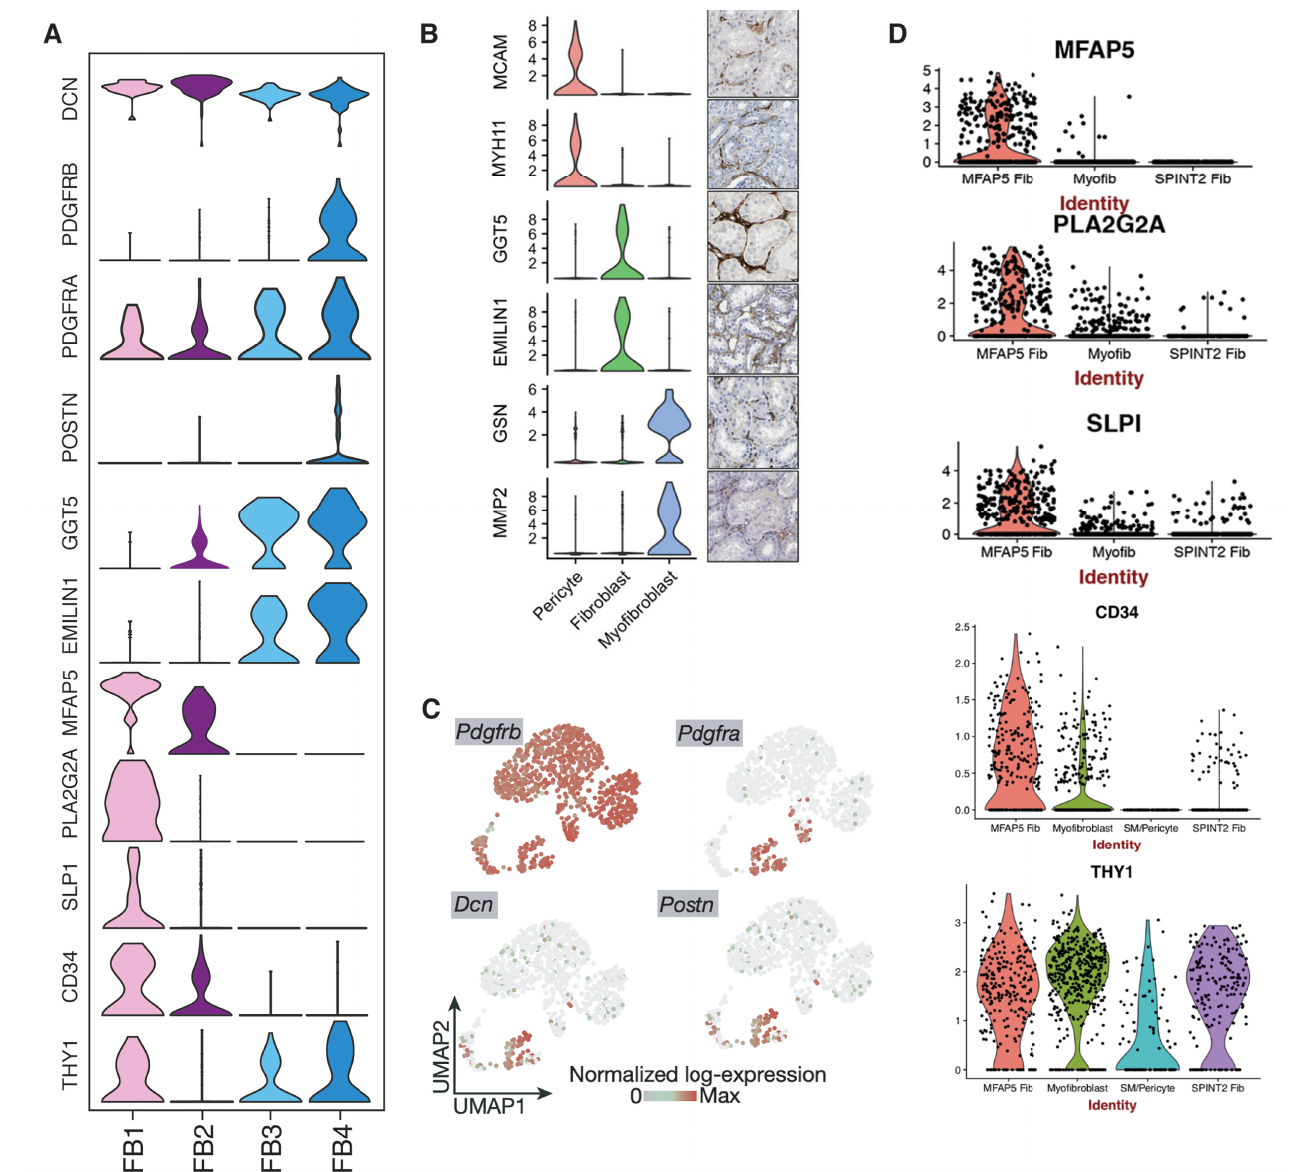
Fig 6. FB1-FB4 subpopulations compared with FBs described in recently published human scRNA-seq studies. (A). Violin plots depicting the expression of marker genes for FB1 to FB4 subpopulations. (B). FBs in a kidney allograft with rejection [29]. (C). FBs in kidneys with CKD due to hypertensive nephrosclerosis [30]. (D). FBs in lungs with systemic sclerosis-associated interstitial lung disease